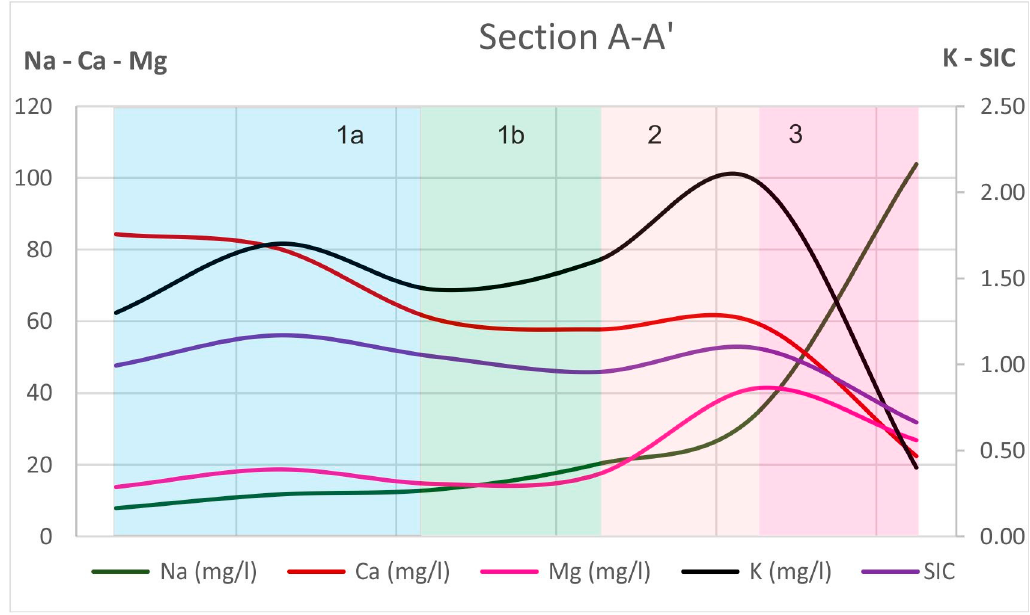
Figure 8. Variations in the concentration/values of major cations and SI (Saturation Index) of calcite along the groundwater flow.